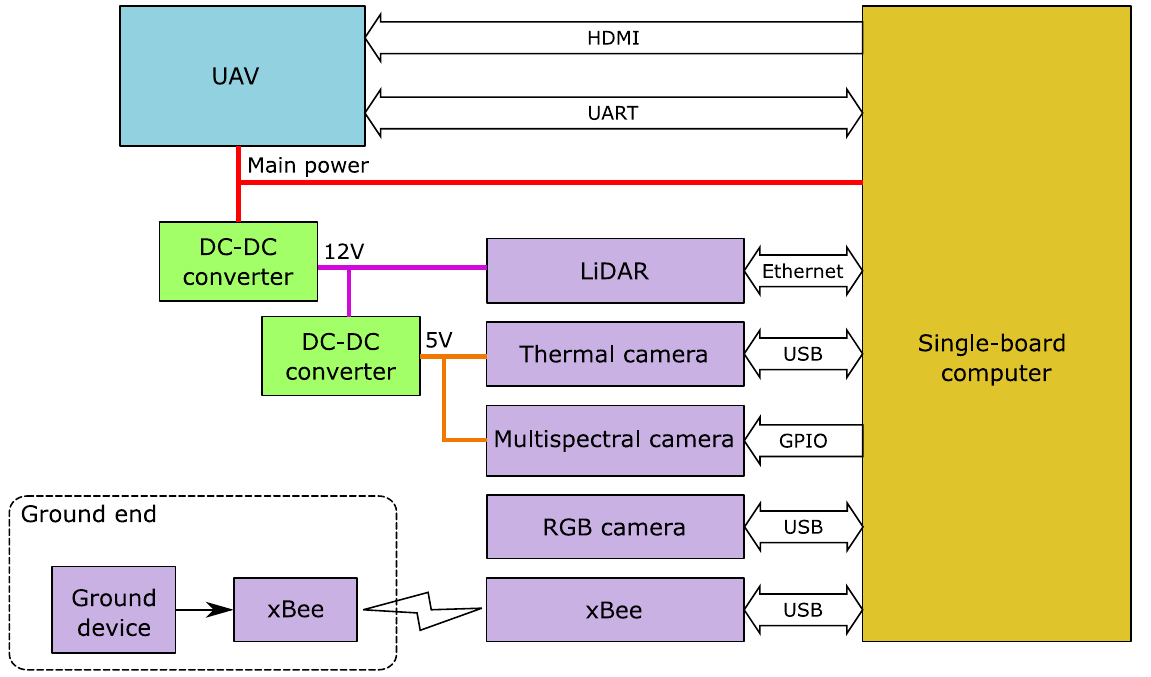
Figure 4. Diagram of the electronic connection of the